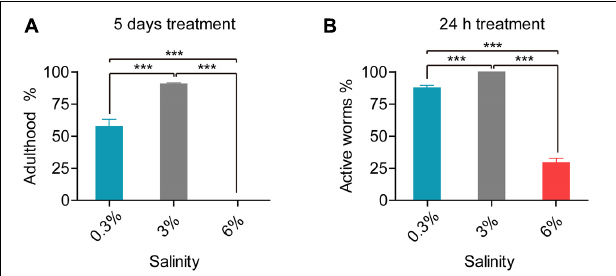
FIGURE 1 | Developmental and behavioral defects in L. marina responding to salinity stresses. (A) For developmental analysis, 30 newly hatched L1s were transferred onto each indicated 3 cm-dimeter agar plates seeded with 15 µ l OP50. The number of adult worms was scored 120 h (5 days) post-treatment. No adults was observed under 6% salinity condition. Four replicates were performed for each experimental condition. (B) For behavioral analysis, 30 newly hatched L1s were transferred onto each indicated 3 cm-dimeter agar plates seeded with 15 µ l OP50. Worms were scored as active if response was detected after prodding with a platinum wire 24 h post-treatment. Specifically, 100% of tested worms are active on the control plates (3%). Six replicates were performed for each experimental condition. Error bars represent the standard error of the mean from replicated experiments. Differences between groups were analyzed statistically employing the two-tailed Student’s t -test using IBM SPSS Statistics 19 software. P < 0.05 was considered statistically significant. *** P <